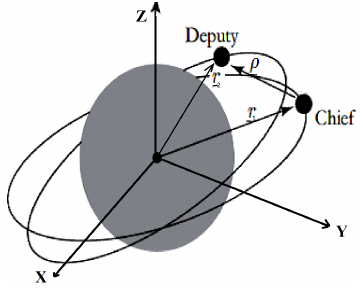
Fig. 1 Geometry of Satellites